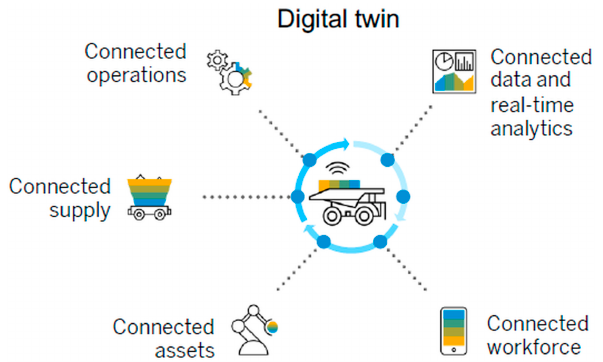
Figure 8. The use of a digital twin in Mining 4.0 (Reprinted from Ref. [63]).